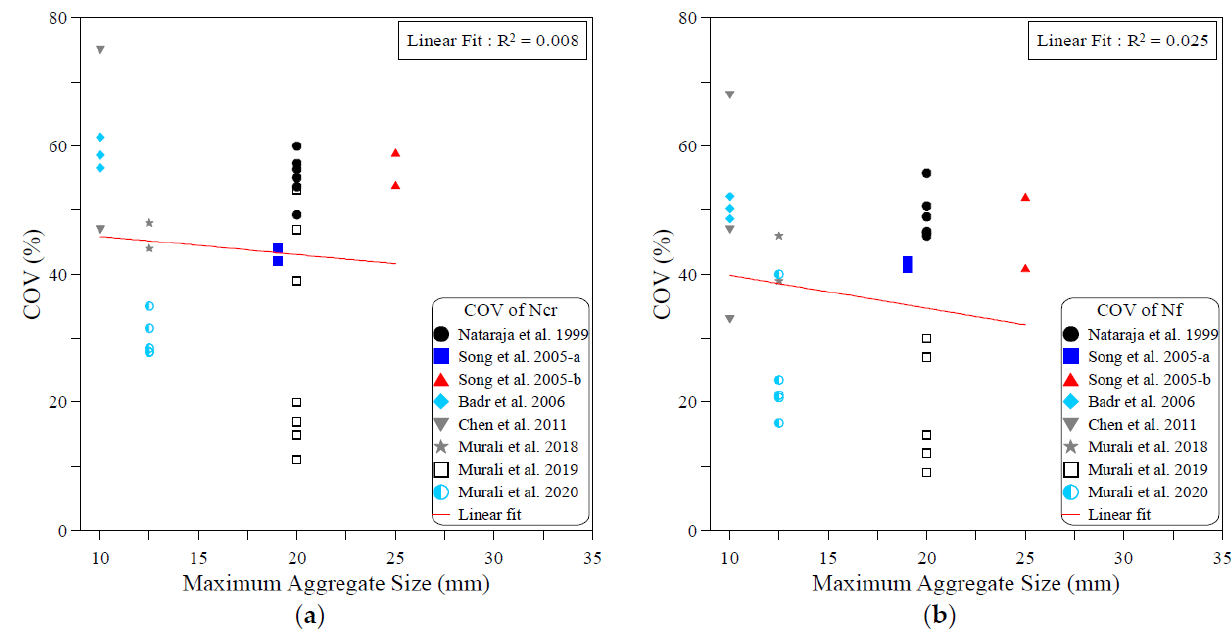
Figure 4. Effect of maximum size of aggregate on the scattering of impact results at ( a ) cracking and ( b ) failure.